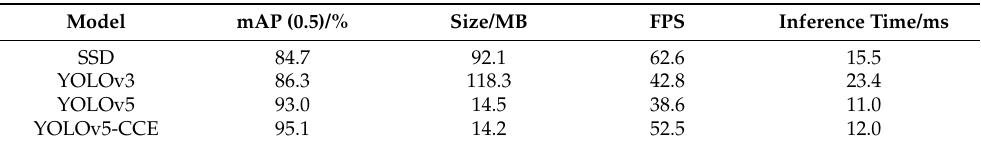
Figure 9. Results of different models on the data set. ( a ) The change curve of mAP (0.5), ( b ) The change curve of loss. Table 5. Results of different